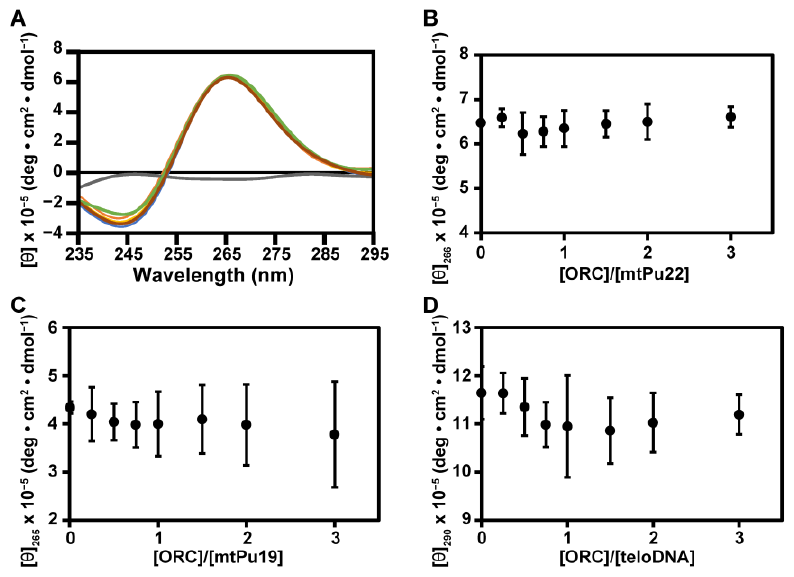
Figure 3. Effects of hORC1 413–511 upon titration on structures of G-rich DNAs monitored by CD. ( A ) CD spectra of the complex at molar ratios of [hORC1 413–511 ]/[mtPu22] = 0.0 (blue), 0.5 (brown), 1.0 (yellow), 1.5 (green), and 2.0 (orange). CD spectrum of hORC1 413–511 is in gray. ( B – D ) The values of (θ) are plotted against [hORC1 413–511 ]/[G-rich DNA] for mtPu22 ( B ), mtPu19 ( C ), and teloDNA ( D ). All experiments were performed in duplicate and the standard deviation is indicated for each point.